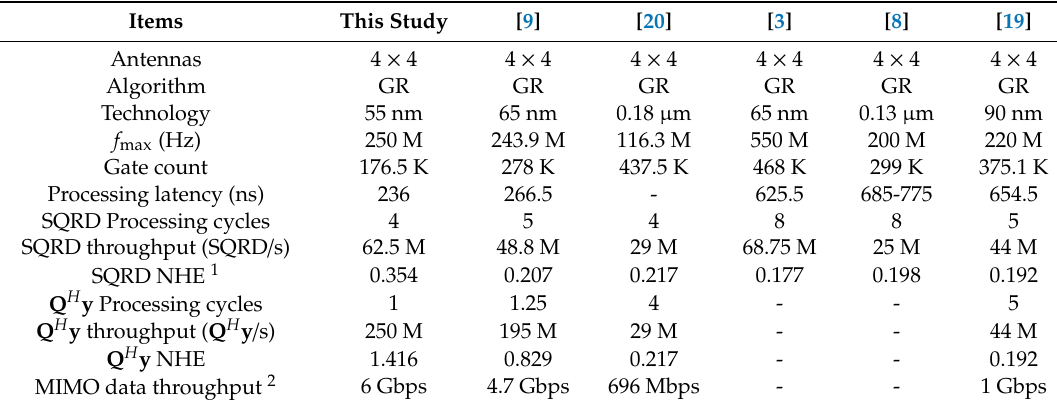
Table 2. Implementation results and performance